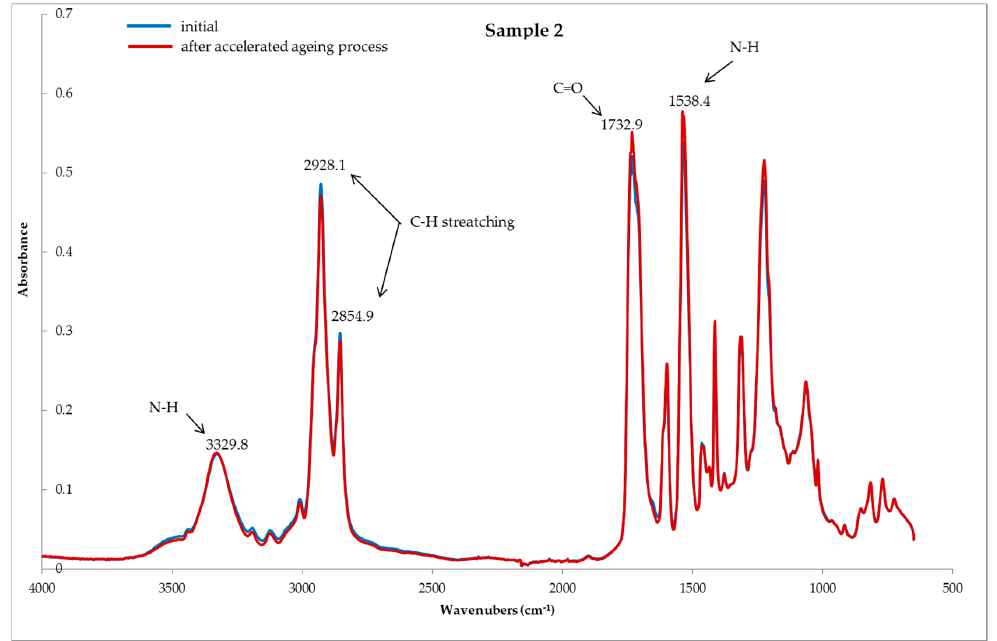
Figure 3. FTIR spectra of sample 2; samples, --- initial (before) and --- after the accelerated aging process.